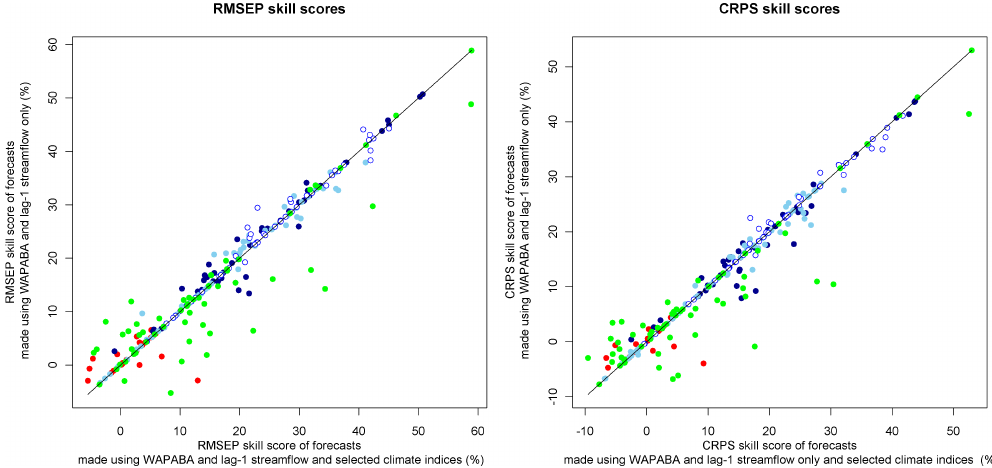
Fig. 12. The contribution of selected climate indices to forecast skill illustrated by plotting skill scores of forecasts made without using climate indices as predictors against skill scores of forecasts made with selected climate indices as predictors for the RMSEP (left panel) and CRPS (right panel) skill scores. All forecasts use WAPABA simulations and lag-1 streamflows as predictors to represent the influence of initial catchment conditions. (Legend as per Fig.